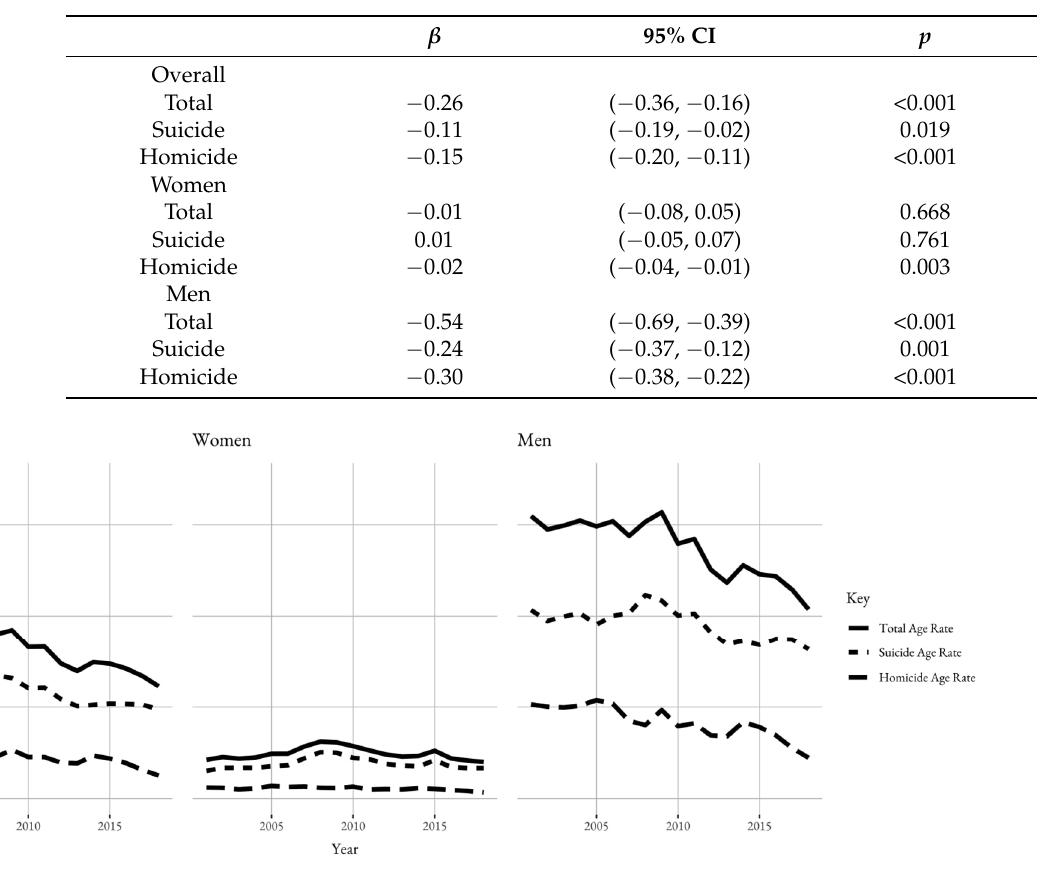
Figure 1. Age-adjusted violent mortality rates in Chile, 2001–2018.